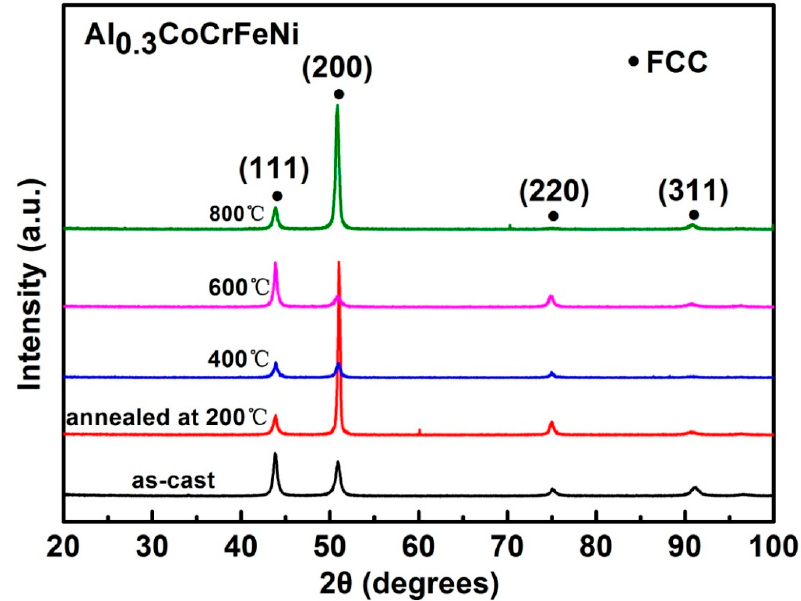
Figure 2. X-ray diffraction (XRD) patterns of the annealed Al 0.3 CoCrFeNi.